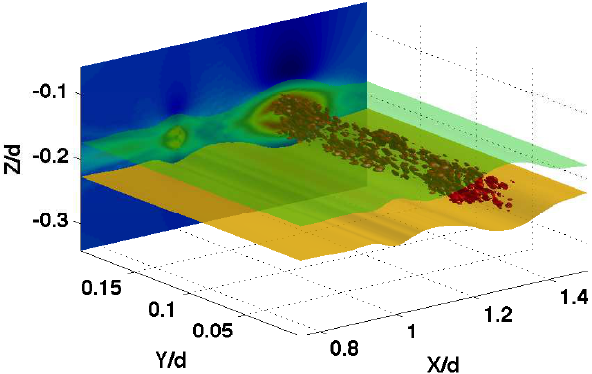
Fig. 13. Similar layout to Fig. 12 for the 20% case. Note the signif- icant amount of spanwise flow traveling with the core of the initial mode-2 wave. Image output at t = 37 . 5s. Isosurfaces of the span- wise velocity field were taken at 5% of its maximum value. Scaling d =